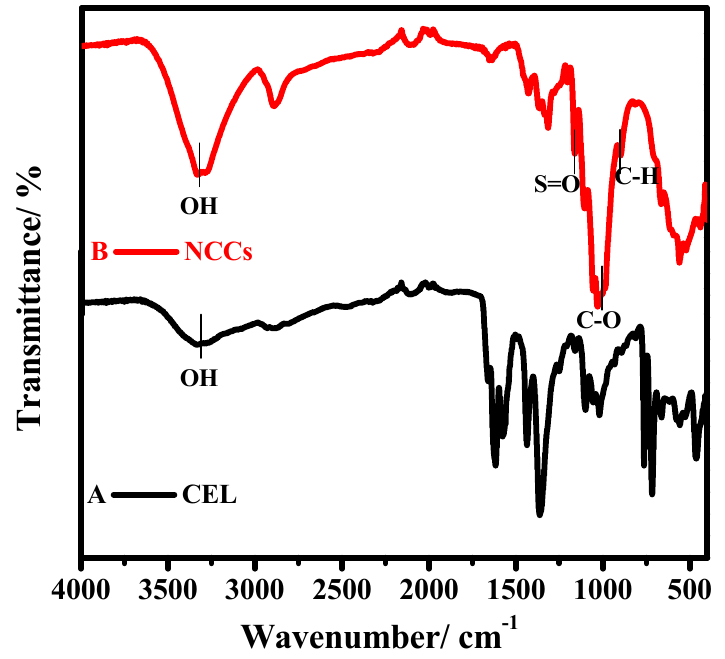
Figure 2. FTIR spectra of ( A ) CEL and ( B ) NCC.